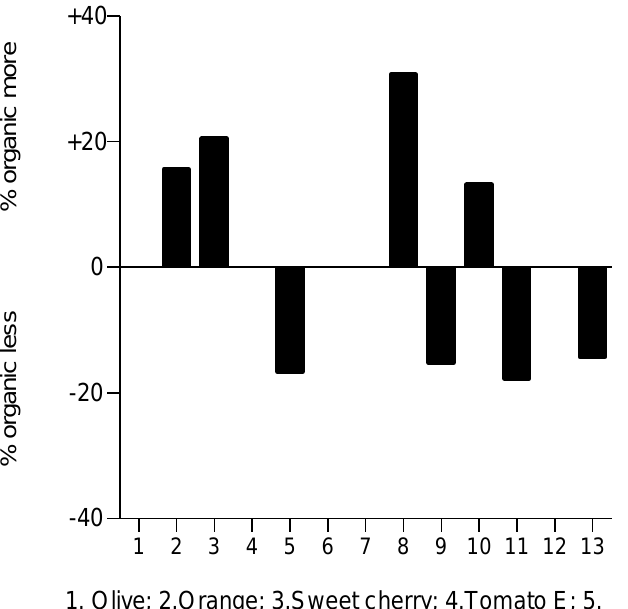
Figure 3. Distribution of variability in ORAC values of organic plant-based foods compared to the non-organic ones. Each point representing the % variability in ORAC values of the same plant-based food and cultivar, which is labeled with a number. That is, plus and minus signs refer to more or less abundance of an ORAC value from an organic sample with respect to non-organic sample as the baseline for comparison. Abbreviations: Hazelnut C, hazelnut cv. Castanyera; Hazelnut N, hazelnut cv. Negreta; ORAC, oxygen radical absorbance capacity; NORG, non-organic farming; ORG, organic farming; PPC, phenolic compounds content; Tomato E, tomato cv. Ekstasis; Tomato T, tomato cv.